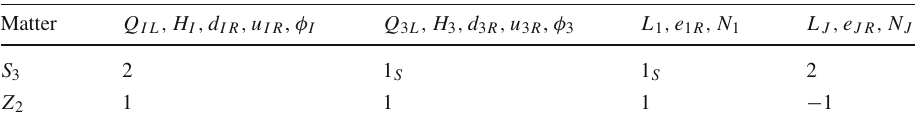
Table 1 Flavored B − L